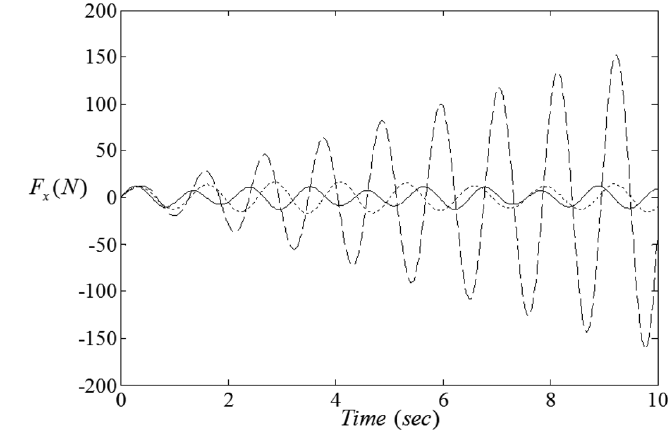
Fig. 8. The resultant hydrodynamic force under the harmonic excitation for R 1 / R 2 = 0.6 and three different h 1 / R 2 ( h 1 / R 2 = 0.1, ······ h 1 / R 2 = 0.3, − − − h 1 / R 2 =